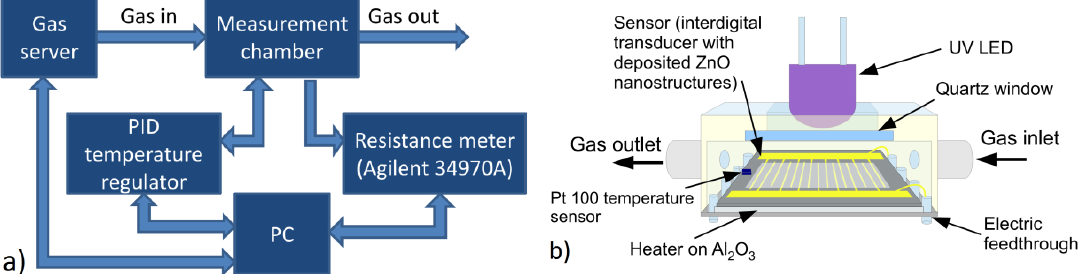
Figure 1. Scheme of ( a ) the measurement stand and ( b ) the measurement chamber.